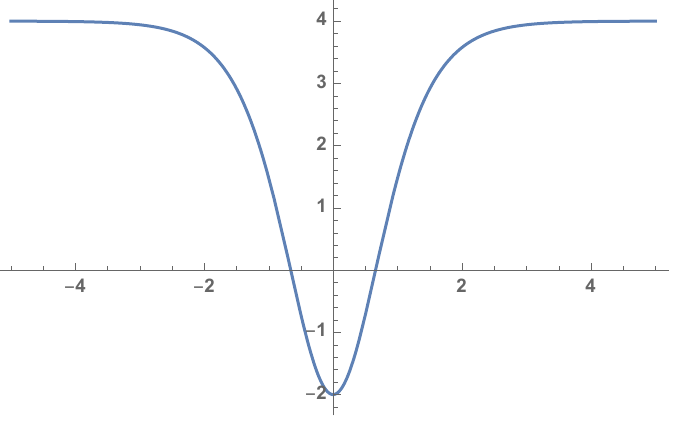
Figure 1 . Potential due to scalar (cid:12)eld symmetry breaking to the equation 6 tanh[ z ] 2 (cid:0)